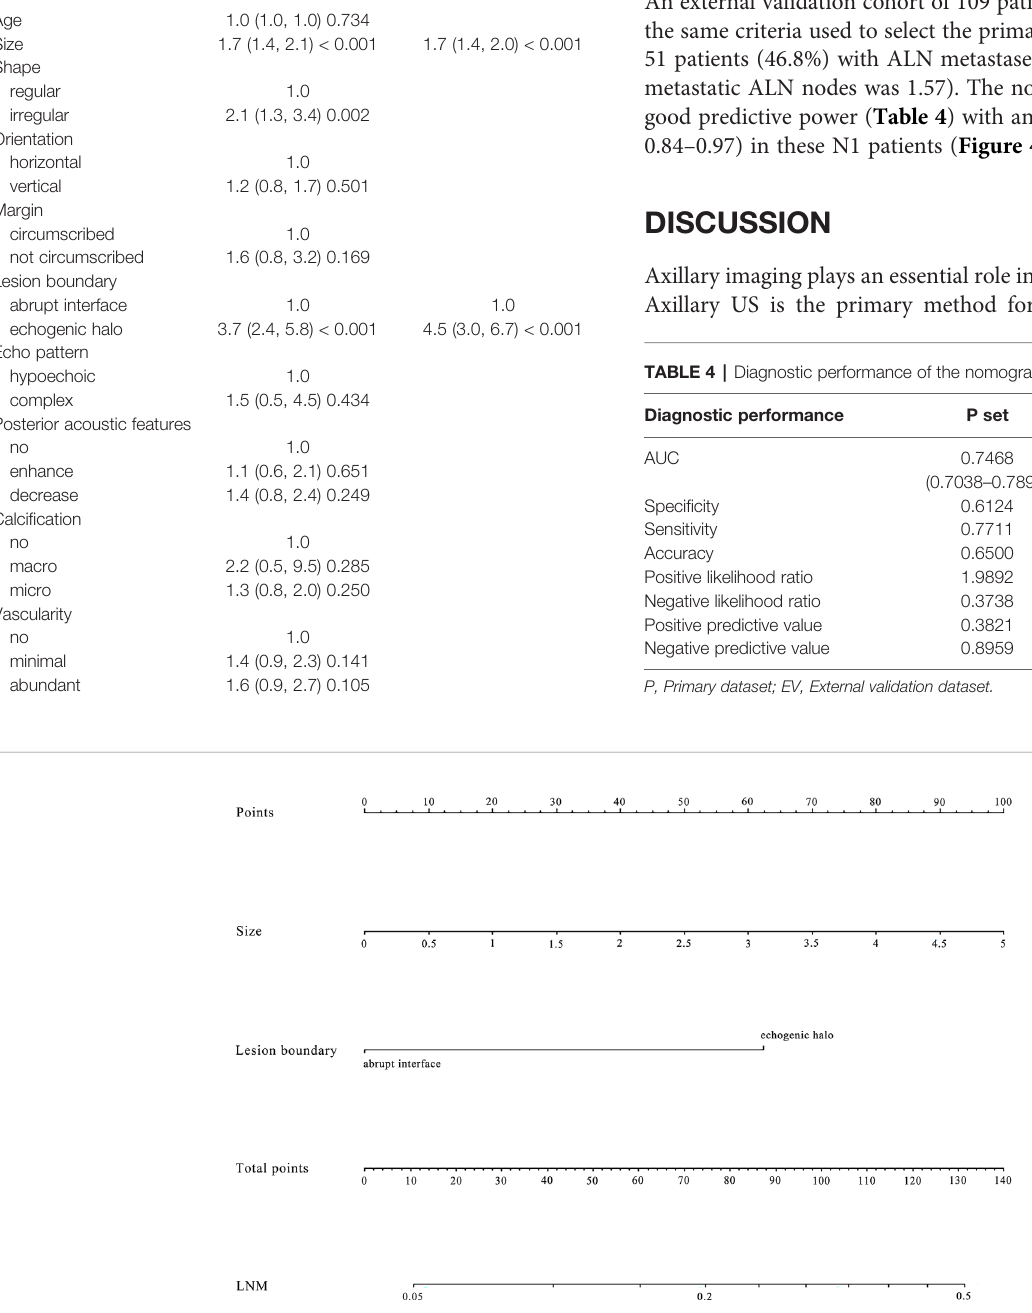
TABLE 3 | Results of Univariate and Multivariate logistic regression analysis in the primary cohort. Exposure